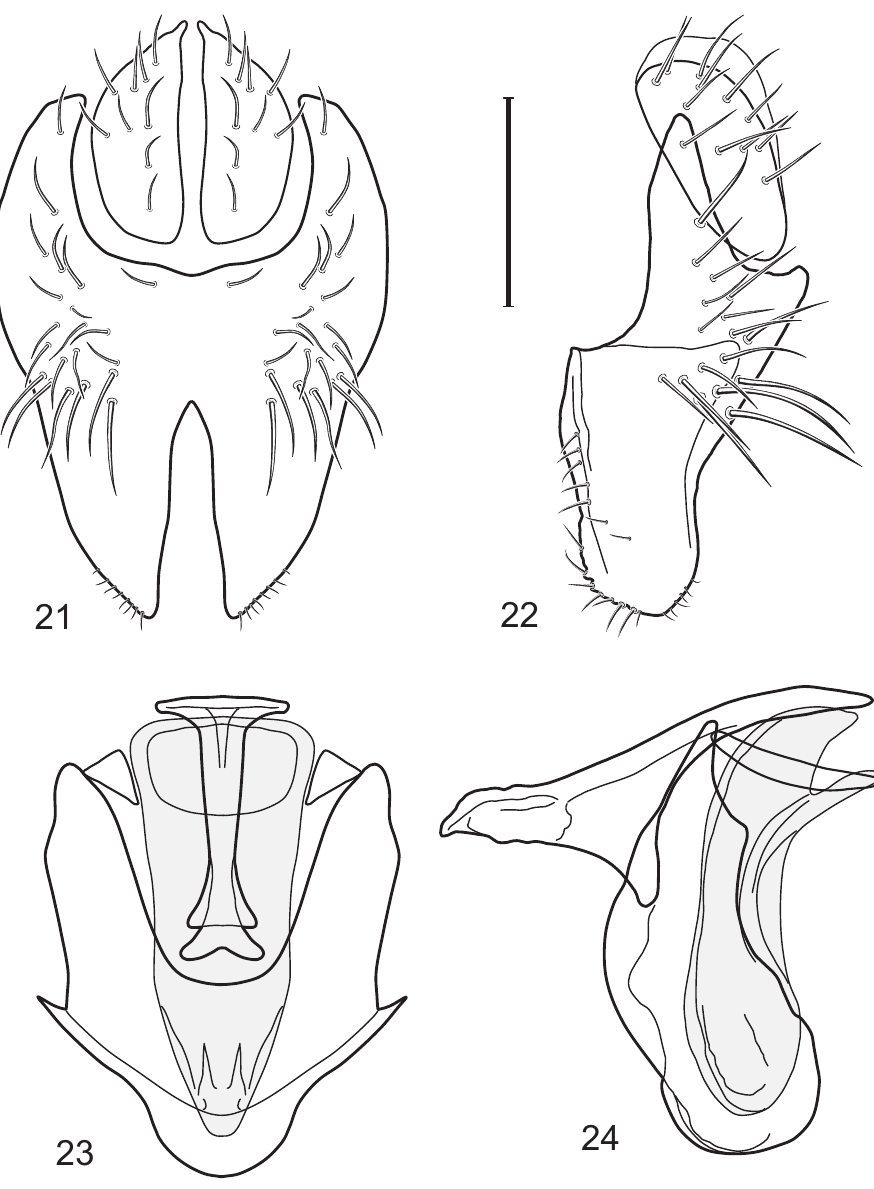
Figures 21–24. Hydrochasma faciale (Williston) (Dominica: Layou R.) 21 epandrium and cerci, posteri- or view 22 same, lateral view 23 internal structures of male terminalia (aedeagus [shaded], phallapodeme, gonite, hypandrium), ventral view 24 same, lateral view. Scale bar = 0.1 mm. Mountains; 03°18.2'N, 59°39.0'W), 29 Apr 1995, W. N. Mathis (2 ♂ ; USNM); Pi- rara Ranch and River (03°32.1'N, 59°40.5'W), 24–25 Apr 1995, W. N. Mathis (9 ♂ , 13 ♀ ;